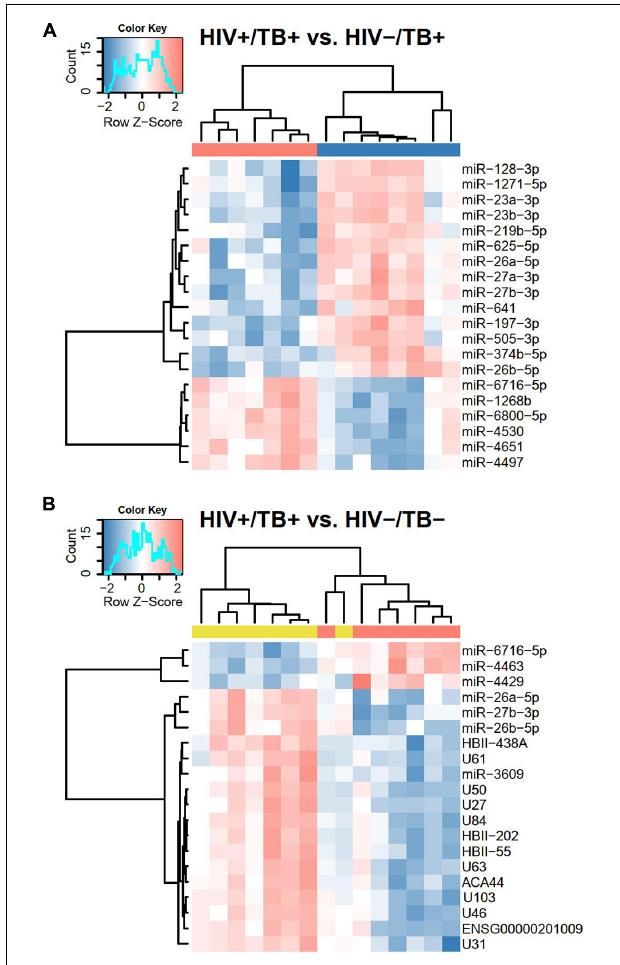
FIGURE 4 | Heatmaps based on hierarchical clustering analyses including (A) HIV+/TB+ and HIV-/TB+ and (B) HIV-/TB- and HIV+/TB+ subjects and the 20 sncRNAs that generated the smallest P -values in Limma analysis from the respective comparisons. Microarray data were median centered before the analysis. Pearson’s correlation was used as a distance matrix. The red and blue colors indicate upregulated and downregulated sncRNAs, respectively. Color codes at the top represent infection status, HIV+/TB+ (red), HIV-/TB+ (blue), and HIV-/TB- (yellow). Probe HBII-438A also assigned to HBII-438B, probe U84 to ENSG00000263442/ENSG00000264591/ENSG00000265325/ ENSG00000265607/ENSG00000266646/ENSG00000266755, probe ACA44 to ENSG00000252840, and probe U103 to